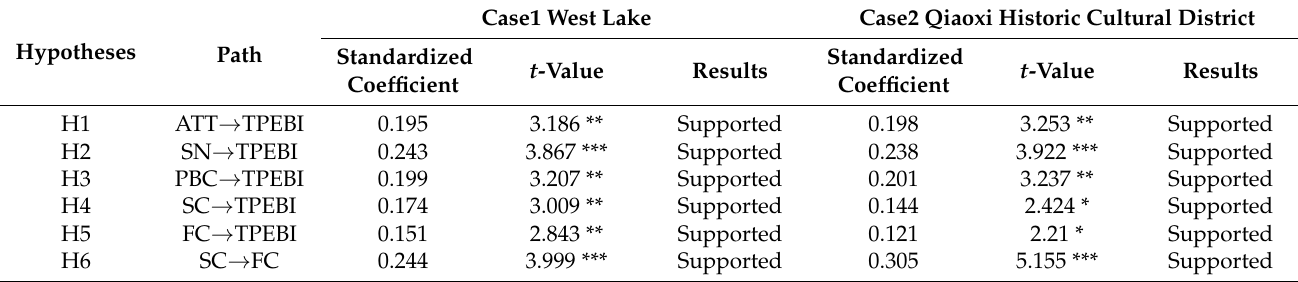
Table 4. Results of the structural model analysis and hypothesis